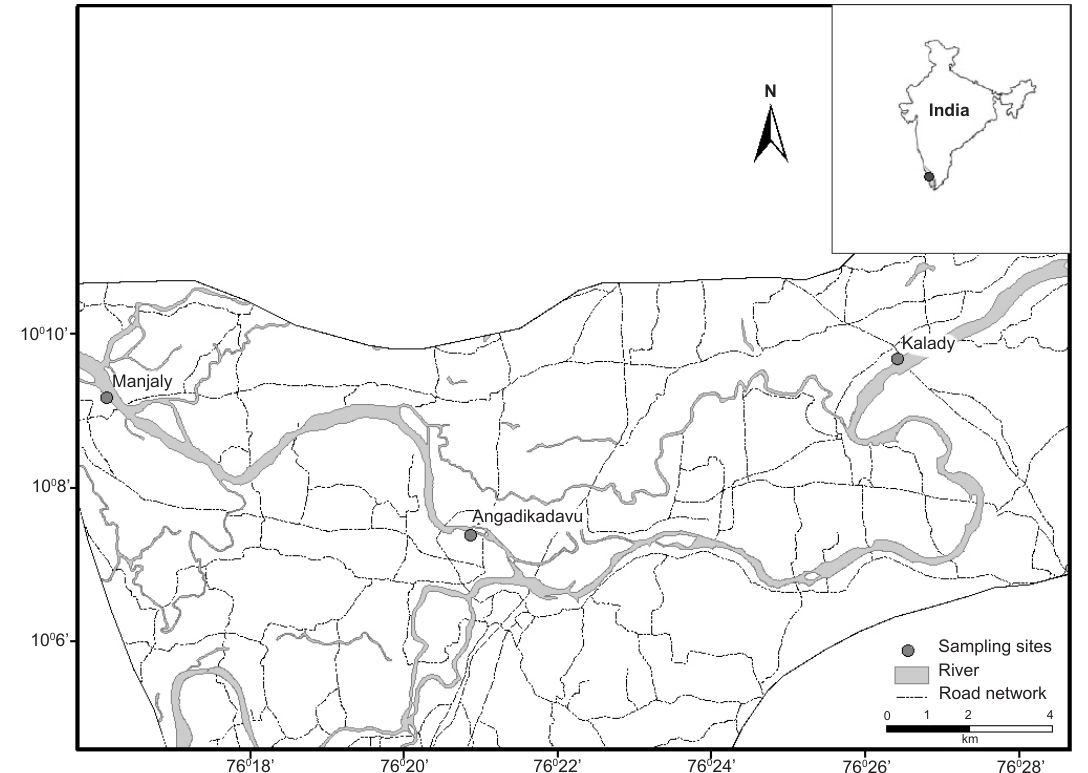
Figure 1. Map showing landing